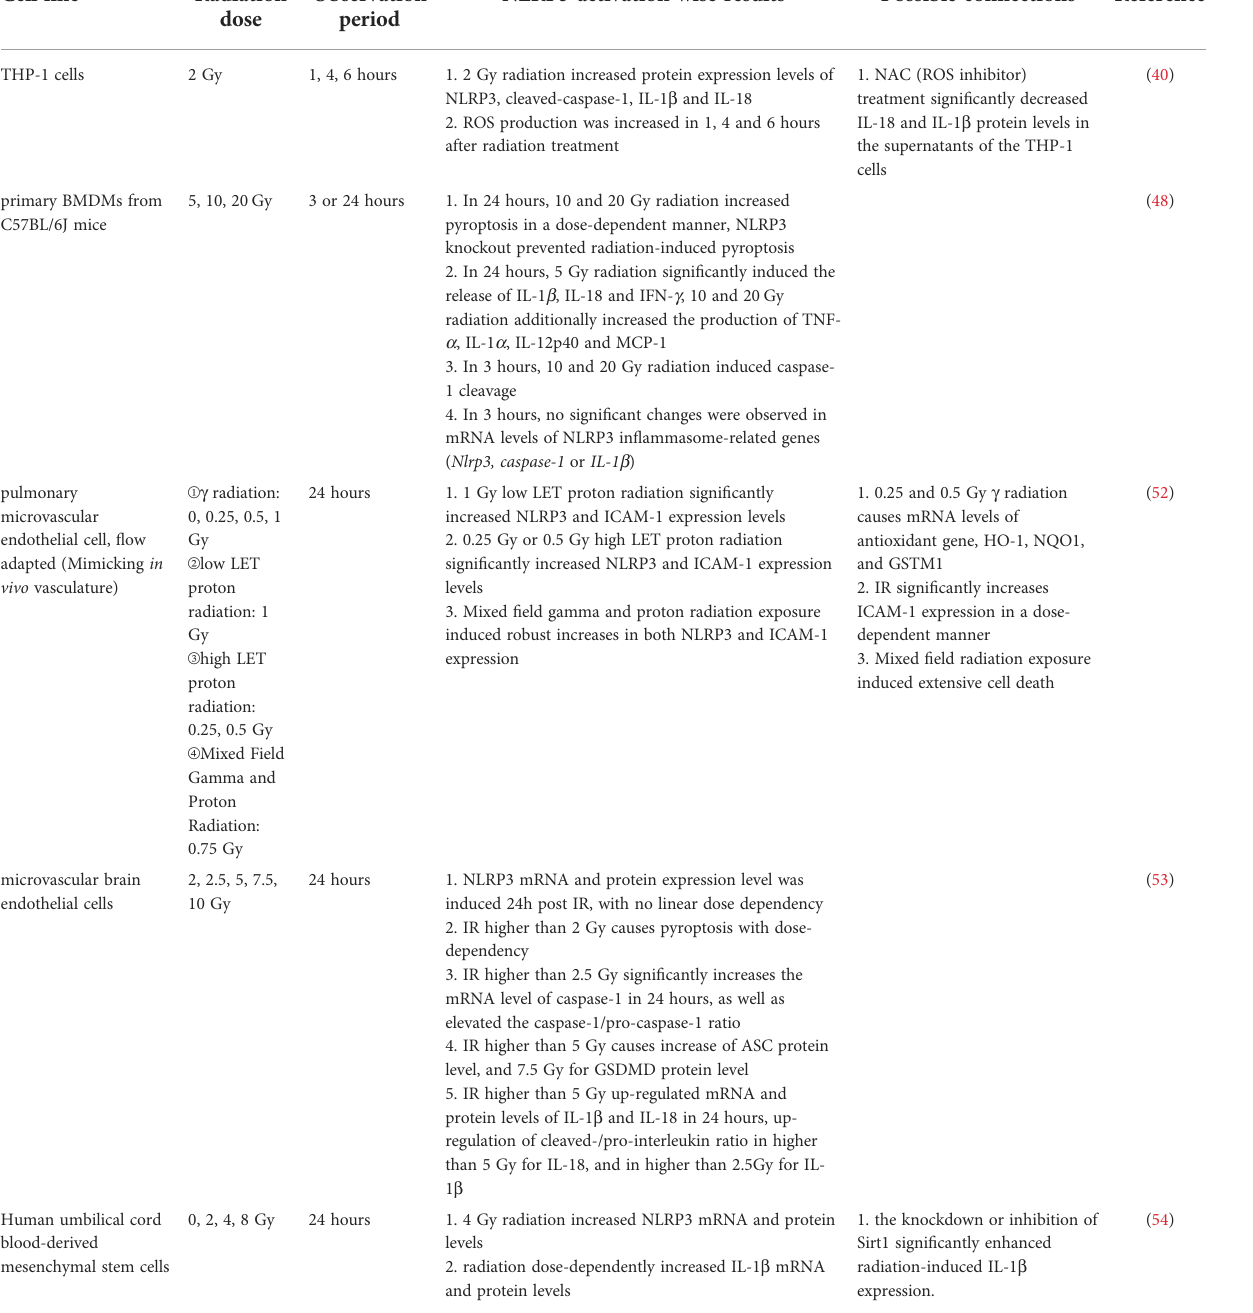
TABLE 2 In vitro studies involving radiation-induced NLRP3 in fl ammasome